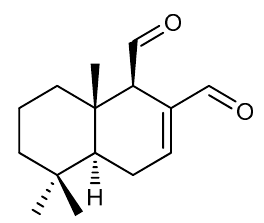
Figure 1. The chemical structure of polygodial.